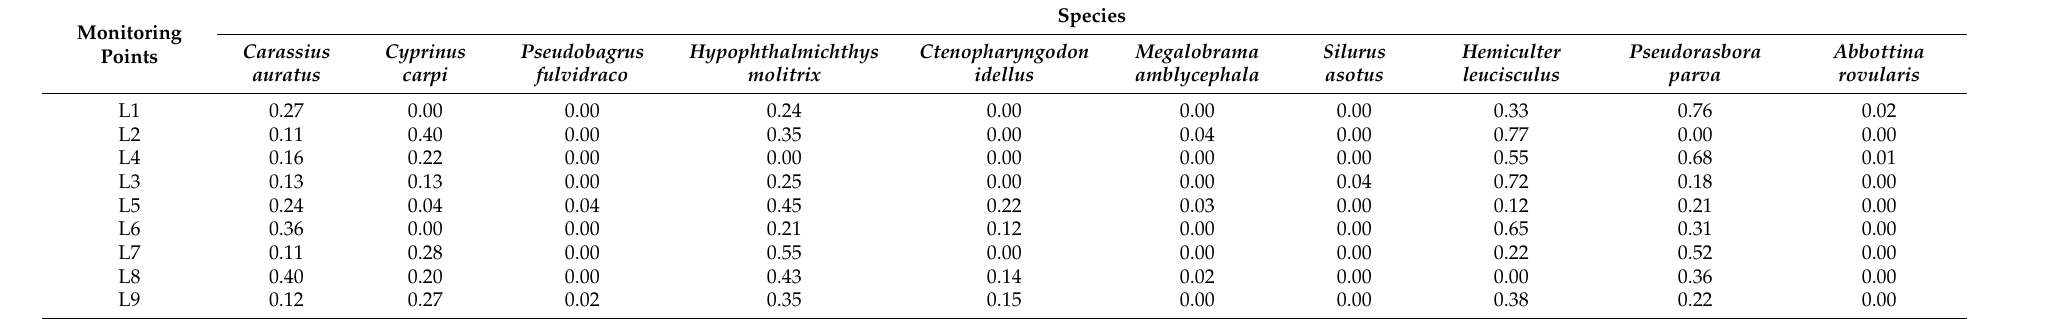
Table 6. Species dominance of lake